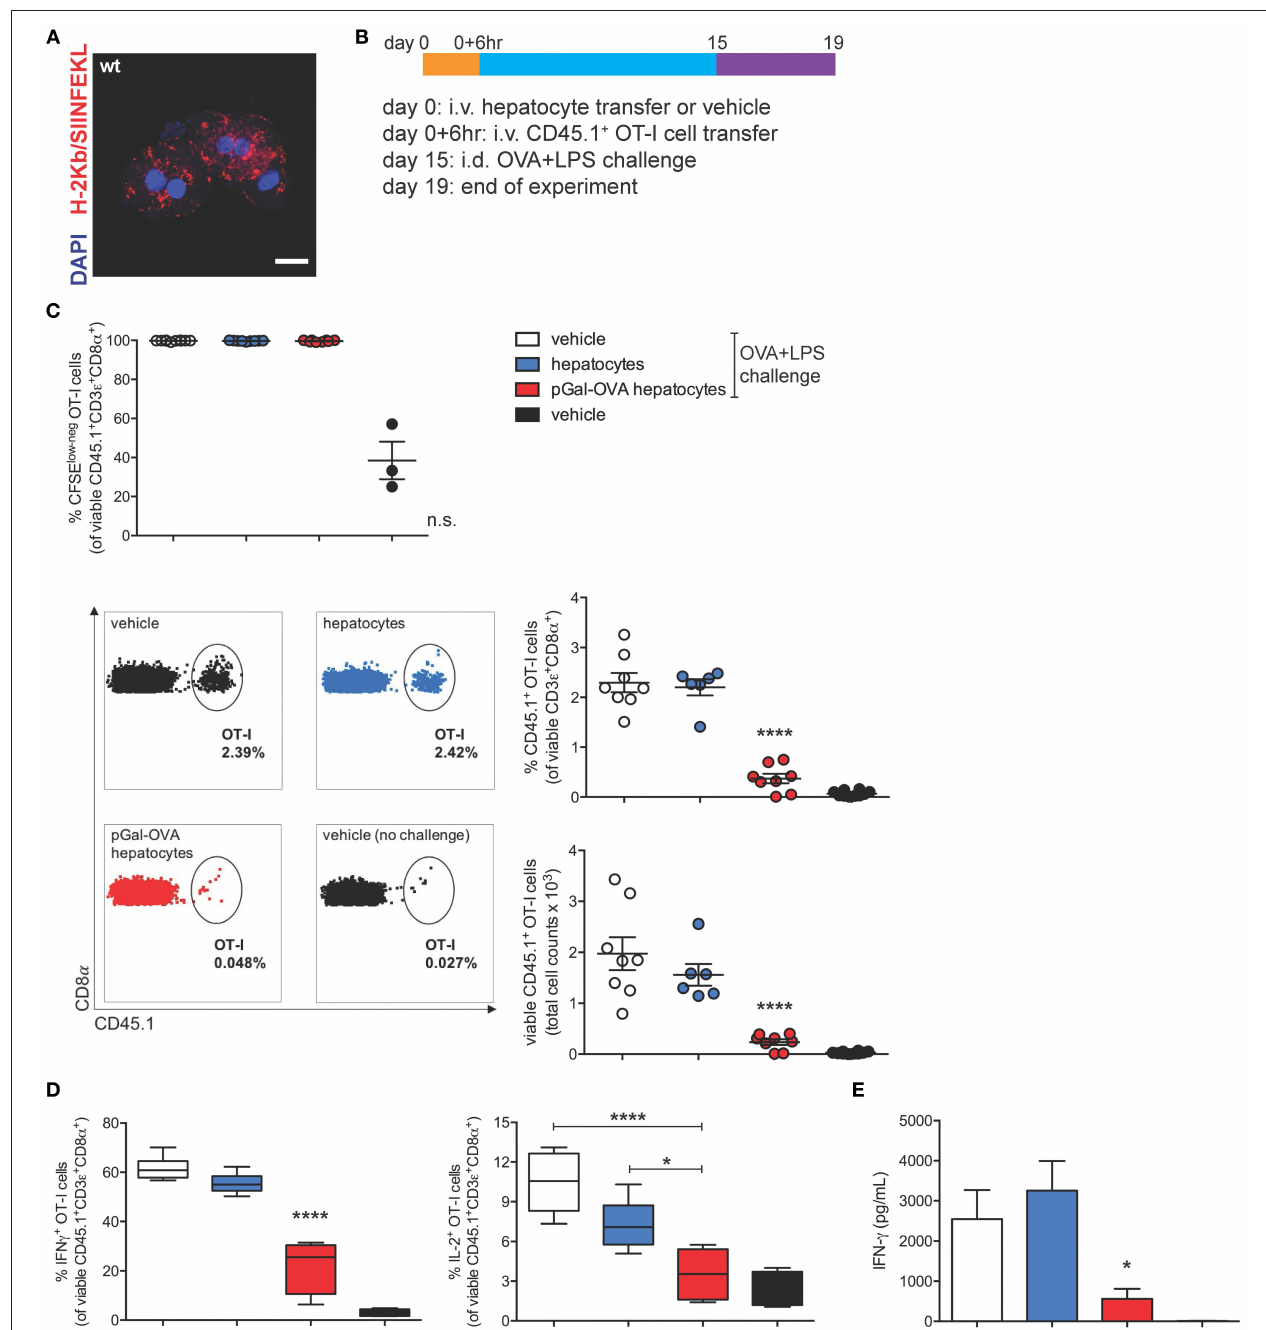
FIGURE 4 | OVA cross-presenting hepatocytes induce CD8 + T cell tolerance of adoptively transferred OT-I cells. (A) Confocal microscopy of primary hepatocytes from C57BL/6 mice incubated ex vivo for 3h with 12.5 µ M pGal-OVA and stained for H-2Kb/SIINFEKL and with DAPI. Scale bar = 10 µ m. (B) Experimental design. Hepatocytes were exposed to antigen ex vivo , prior to intravenous infusion. (C) Proliferation (measured as CFSE dilution) (top) and frequency or total cell counts (bottom) of viable CD3 ε + CD8 α + CD45.1 + OT-I cells were measured by flow cytometry after harvesting from the dLNs of recipient CD45.2 + C57BL/6 mice treated as indicated in (B) . Numbers in the representative dot plots indicate the frequency of CD45.1 + OT-I cells in the population of viable CD3 ε + CD8 α + cells. (D) Upon ex vivo restimulation with OVA 257 − 264 (SIINFEKL), viable CD3 ε + CD8 α + CD45.1 + OT-I cells harvested from the dLNs of CD45.2 + C57BL/6 mice treated as in (B) were stained intracellularly for IFN- γ (left) or IL-2 (right) and analyzed by flow cytometry. (E) IFN- γ secreted by total dLN cells harvested from treated CD45.2 + C57BL/6 mice and restimulated with SIINFEKL was quantified by ELISA. * P < 0.05, **** P < 0.0001 and n.s., not significant for comparisons of pGal-OVA hepatocyte-treated group with either vehicle (plus challenge)- or hepatocyte-treated group (one-way ANOVA and Bonferroni post-hoc test correction). Data are representative of 2 independent experiments ( n = 8; mean and s.e.m. in C–E